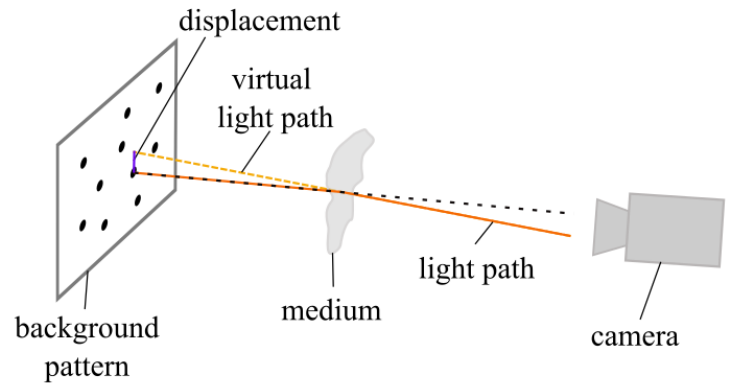
Figure 2. Principle of the background-oriented Schlieren technique (BOS). The changes in refractive index are made visible by algorithmic postprocessing of the images. A simple way of comparing the images of the gas jet together with the background pattern I to the reference image of the background pattern I ref is by pixelwise subtraction of the gray values: